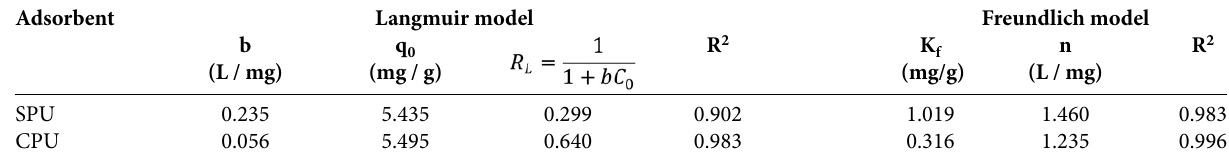
Table 1. Estimated constants for Langmuir and Freundlich isotherm models for the adsorption of Pb (II) ion using SPU and CPU Adsorbent